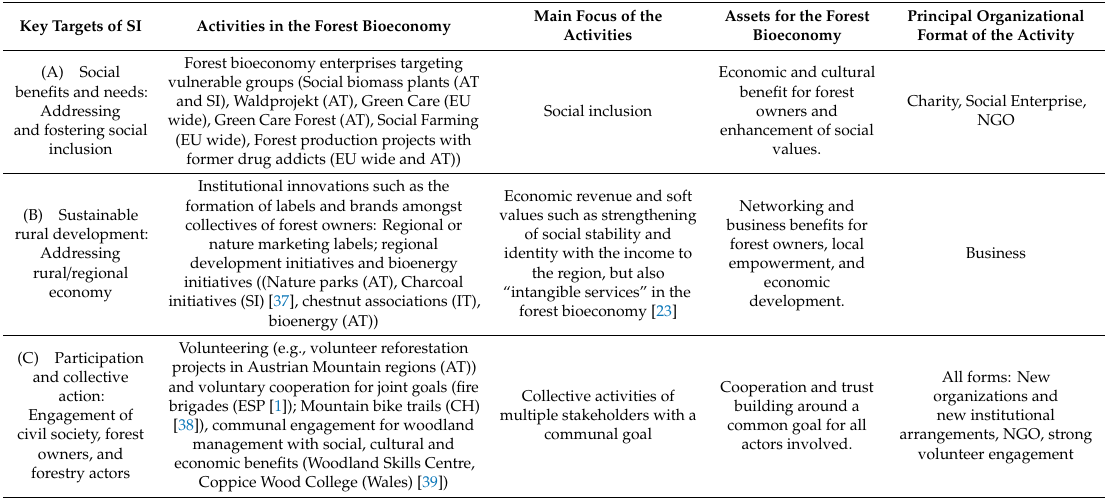
Table 2. Key targets of social innovation in forest bioeconomy social and business activities. Key Targets of